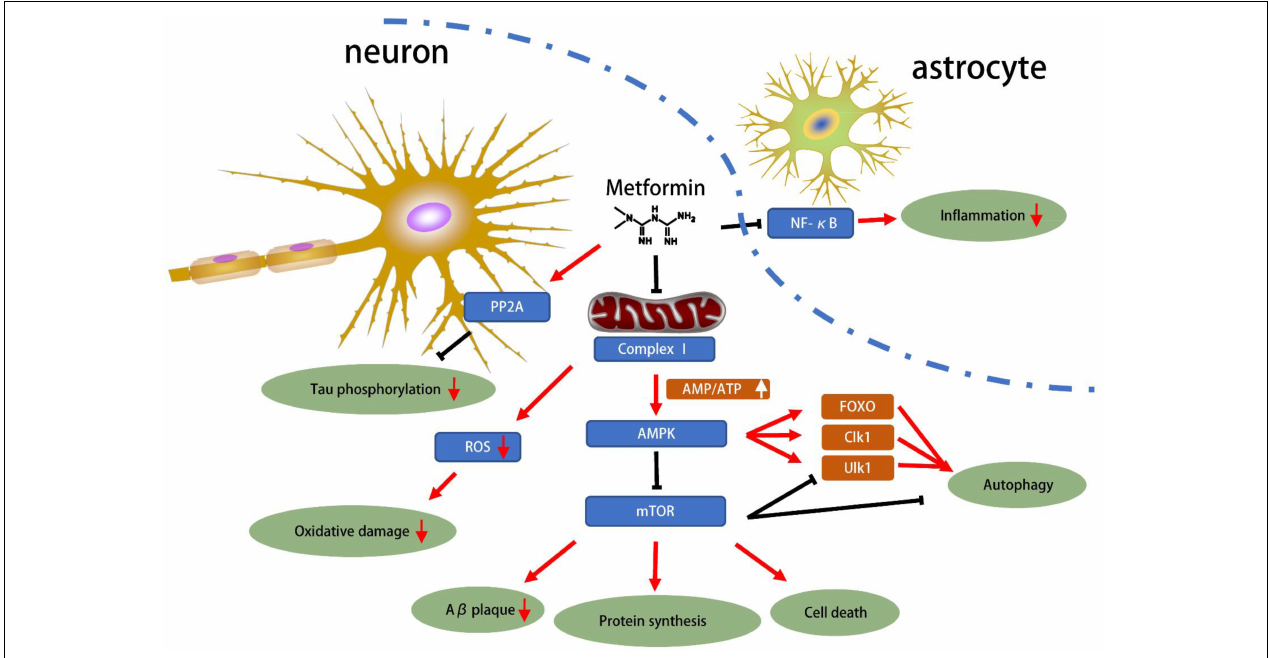
FIGURE 1 | Mechanisms of metformin related to neuroprotection for NDD. The progression of neurodegenerative diseases has been shown to be associated with Tau phosphorylation, oxidative stress, amyloid protein accumulation and inflammation. Metformin can inhibit the NF- κ B pathway, inhibit the astrocyte inflammation. In neurons, metformin directly inhibits Tau phosphorylation through PP2A. Most importantly, metformin inhibits respiratory chain complex 1, which inhibits energy production. This reduces ROS production, increases the AMP/ATP ratio, and then activates AMPK, which in turn inhibits A β plaque, protein synthesis, cell death and autophagy pathways. In general, metformin has great potential for neuroprotection based on current preclinical